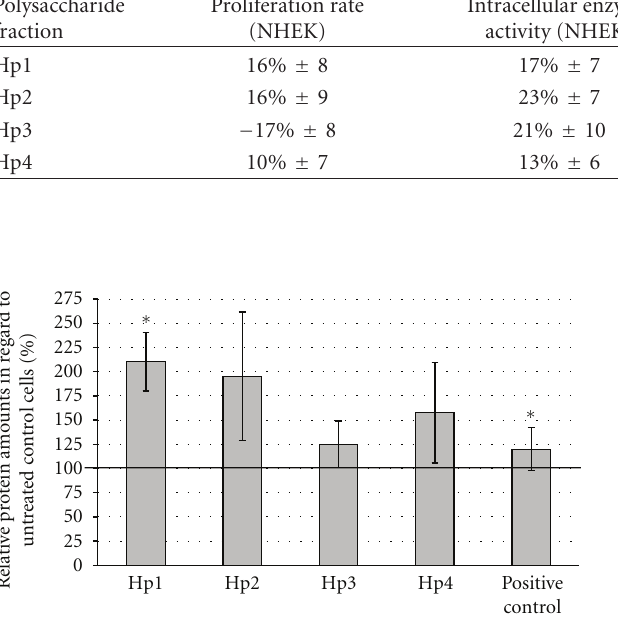
Figure 1: Expression of di ff erentiation-specific protein involucrin of NHEK after treatment with 10 μ g/mL St. John’s Wort polysac- charide fractions for nine days. Protein amounts were determined by semiquantitative dot blot technique. Obtained values with n = 8 were normalized to untreated NHEK (—: untreated NHEK = 100%). To induce the di ff erentiation, the serum-starved MCDB 153 complete media were supplemented with 13 μ g/mL A23187 and 2mM Ca 2+ (positive control).